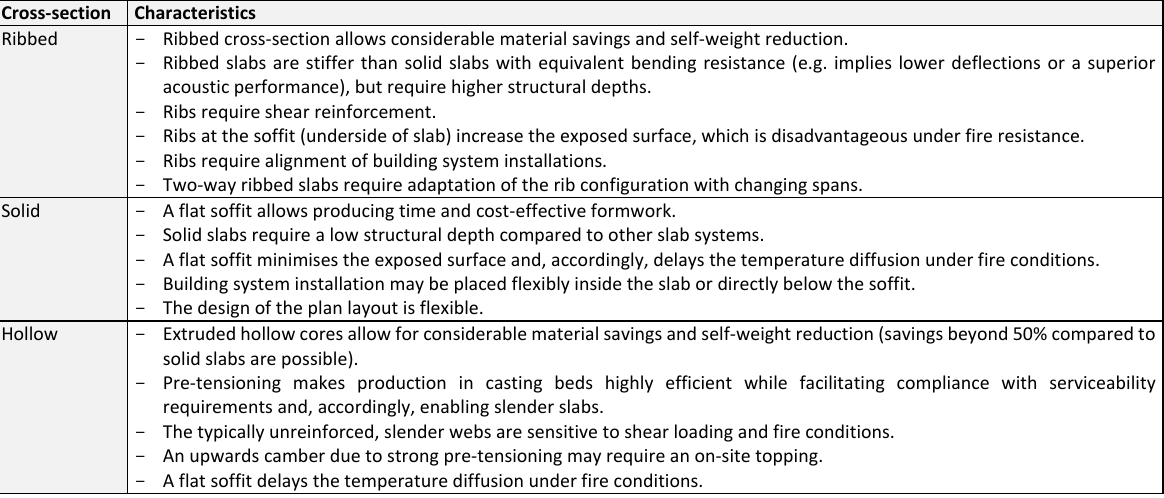
Table 3. Characteristics of reinforced concrete floor